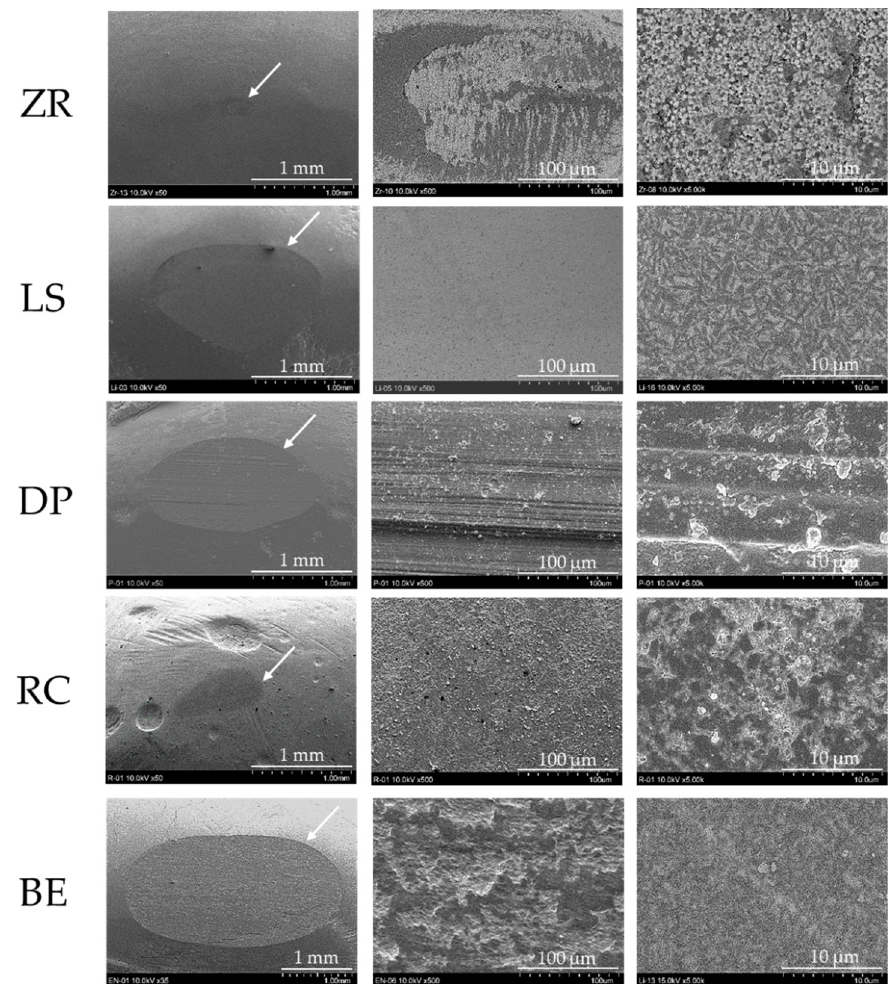
Figure 5. Scanning electron microscopy (SEM) micrographs (left, 50× magnification (only BE: 35× magnification); middle, 500× magnification; right, 5000× magnification) of the worn surface of the abrader specimens. White arrow indicates the wear facet area of the respective specimen. Abbreviations of each experimental group are shown in Table 1.